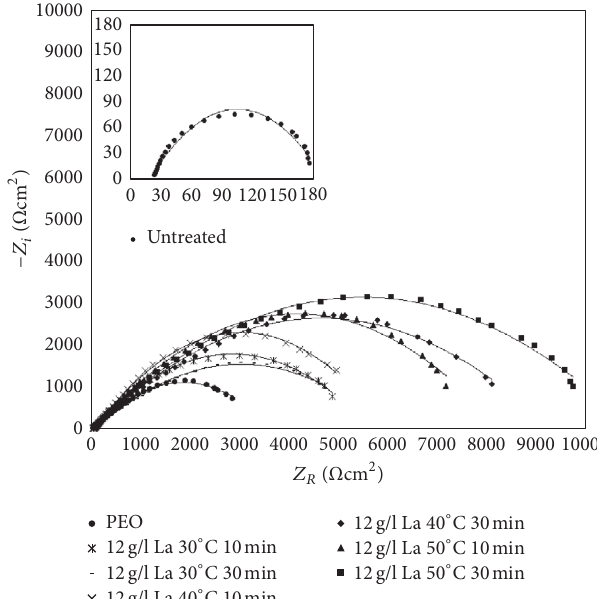
Figure 5: Nyquist plot of AZ91 magnesium alloy PEO coated at 0.5 A/cm 2 and sealed with 12g/l of La(NO 3 ) 3 with different treatment times and